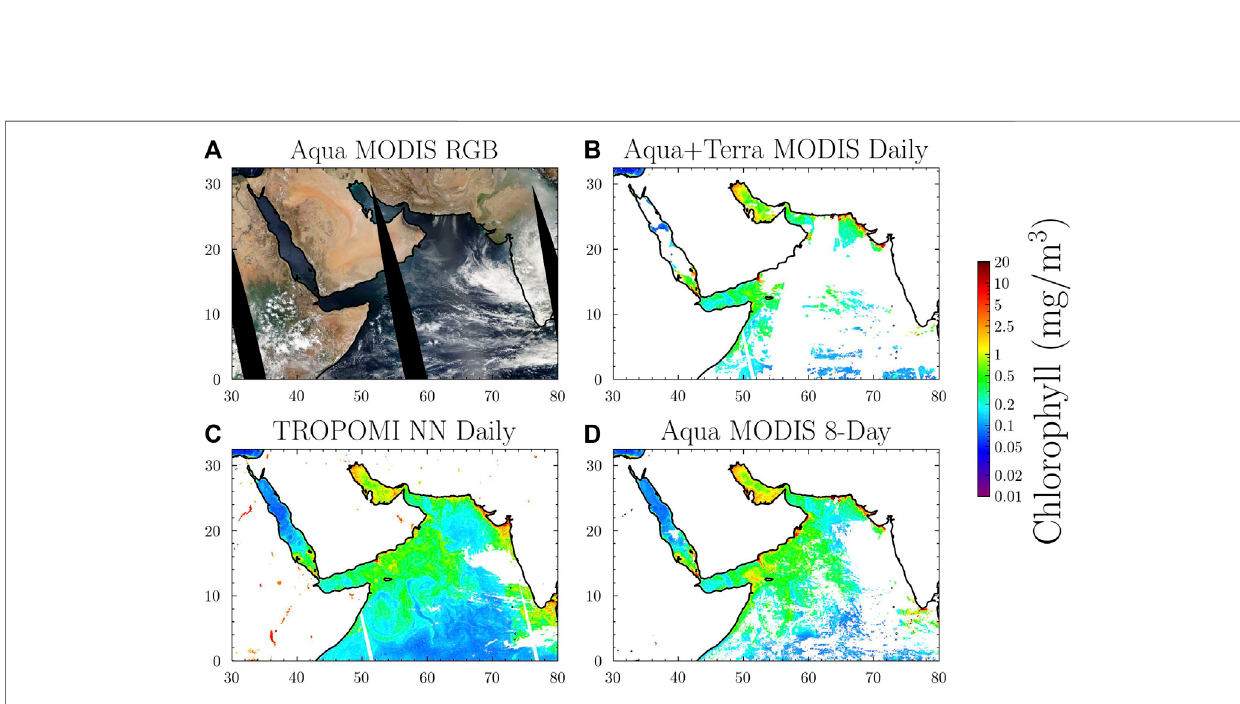
Frontiers in Remote Sensing |